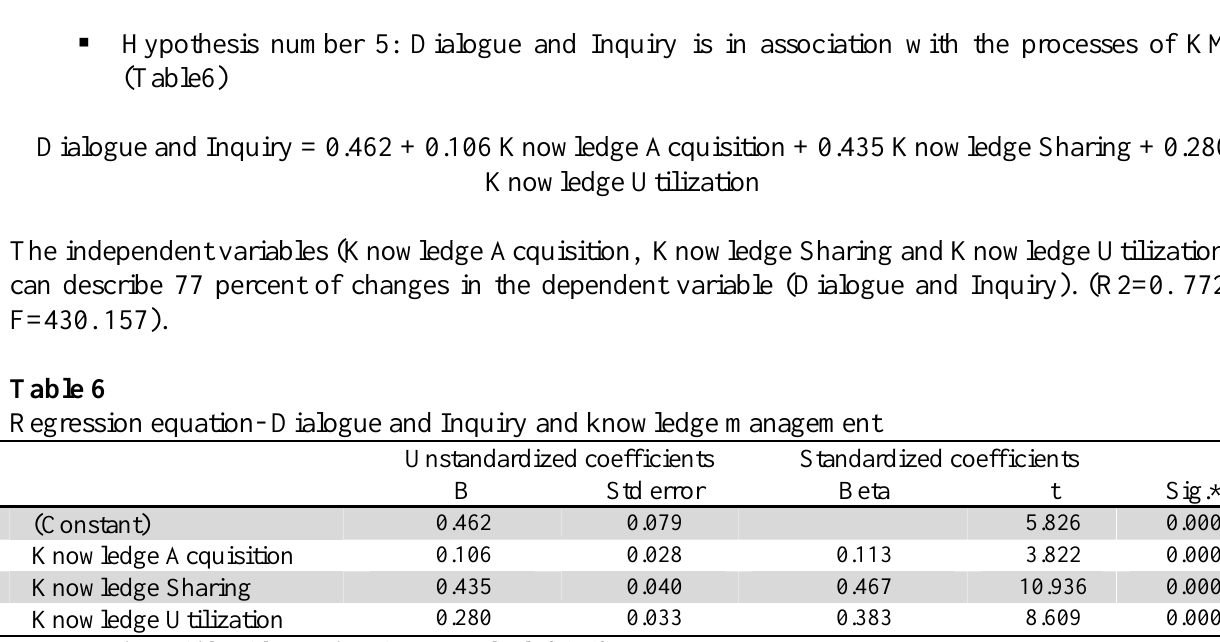
Regression equation- Continuous Learning and knowledge management Unstandardized coefficients Standardized coefficients Knowledge Acquisition